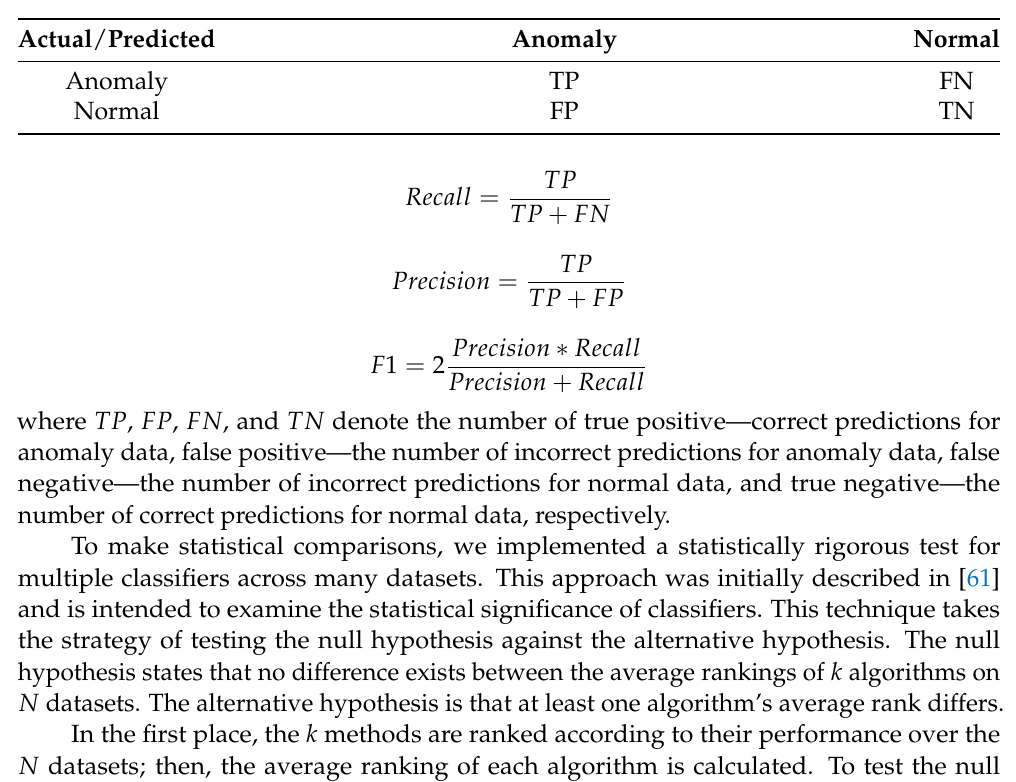
Table 2. Confusion matrix of classification